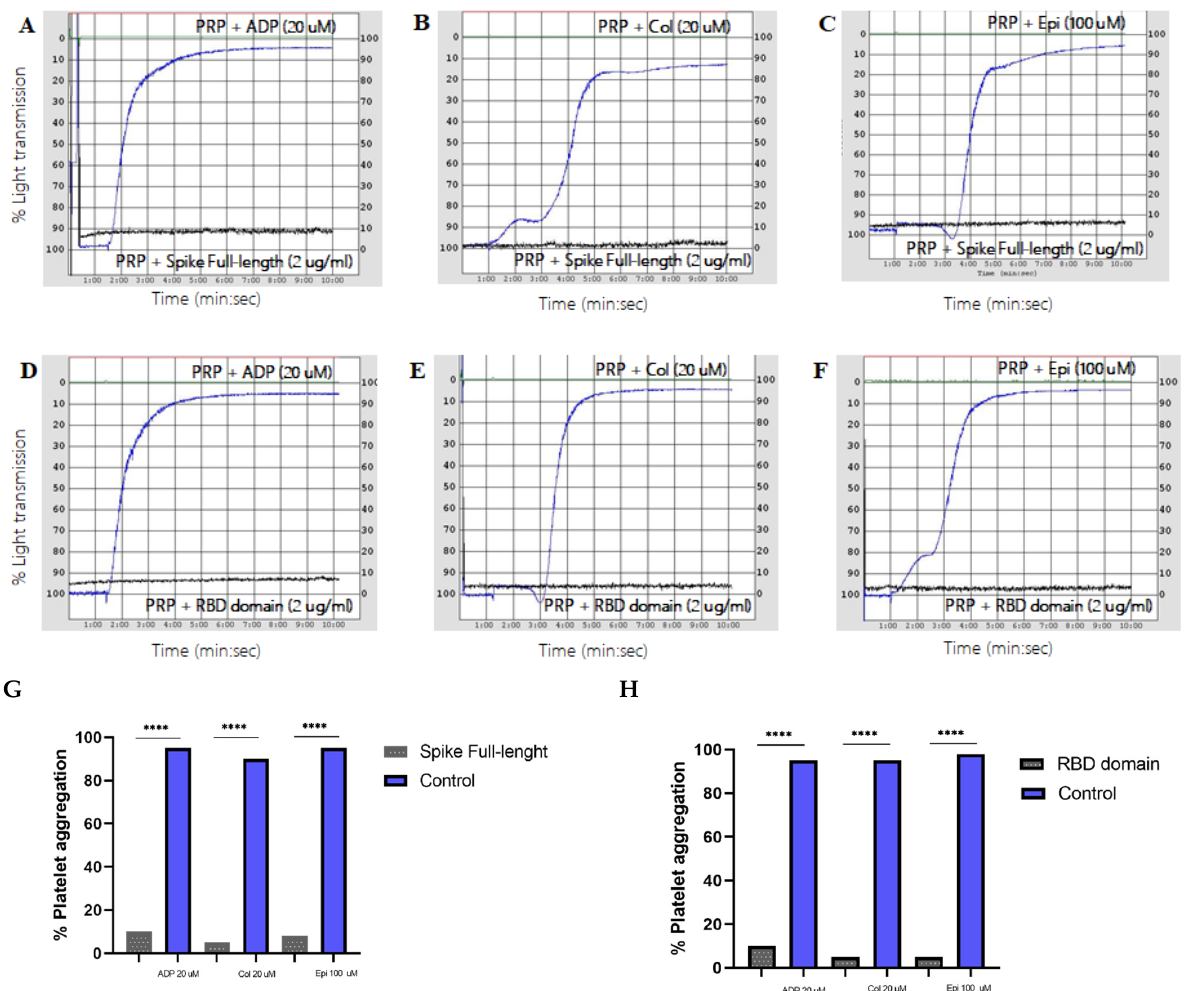
Figure 2. Determination of the aggregation capacity of platelets in response to spike full-length and RBD domain ( A – C ). Platelet-rich plasma (PRP) was incubated with spike full-length protein (2.0 µ g/mL) for 30 min and compared to positive controls stimulated with a dose of 20 µ M ADP, 20 µ M collagen, and 100 µ M epinephrine ( D – F ). PRP was incubated with RBD domain (2.0 µ g/mL) for 120 min and compared to positive controls stimulated with a dose of 20 µ M ADP, 20 µ M collagen, and 100 µ M epinephrine ( G , H ). Comparison of platelet aggregation induced by known agonists when compared to PRP treated with virus proteins. Platelet agonists, but not proteins, were able to induce greater than 80% of aggregation. p values were calculated using one-way ANOVA and Tukey’s post-hoc tests ( n = 3). Data presented as Mean ± SD; ****: Statistical difference p <